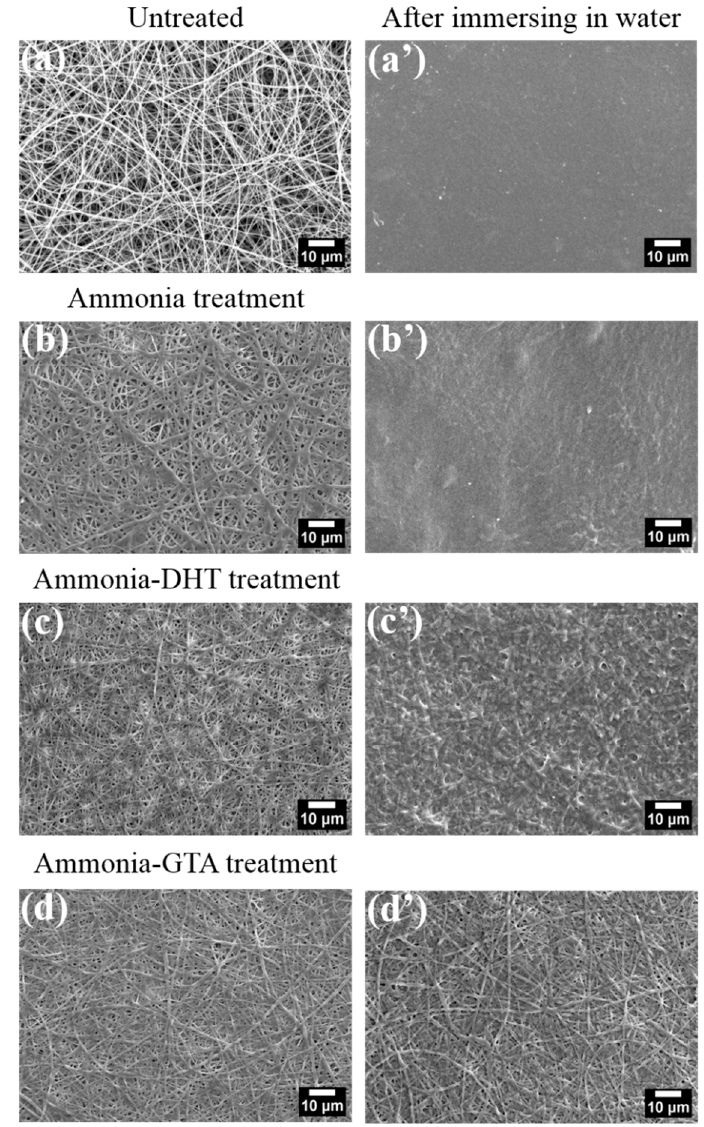
Figure 6. SEM images of electrospun collagen nanofibers before (left column) and after (right column) immersing in water for 1 day at 37 °C. Untreated ( a,a’ ), ammonia treatment ( b,b’ ), ammonia-DHT treatment ( c,c’ ) and ammonia-GTA treatment ( d,d’ ). Table 1. Diameter of collagen nanofibers before and after various treatments.